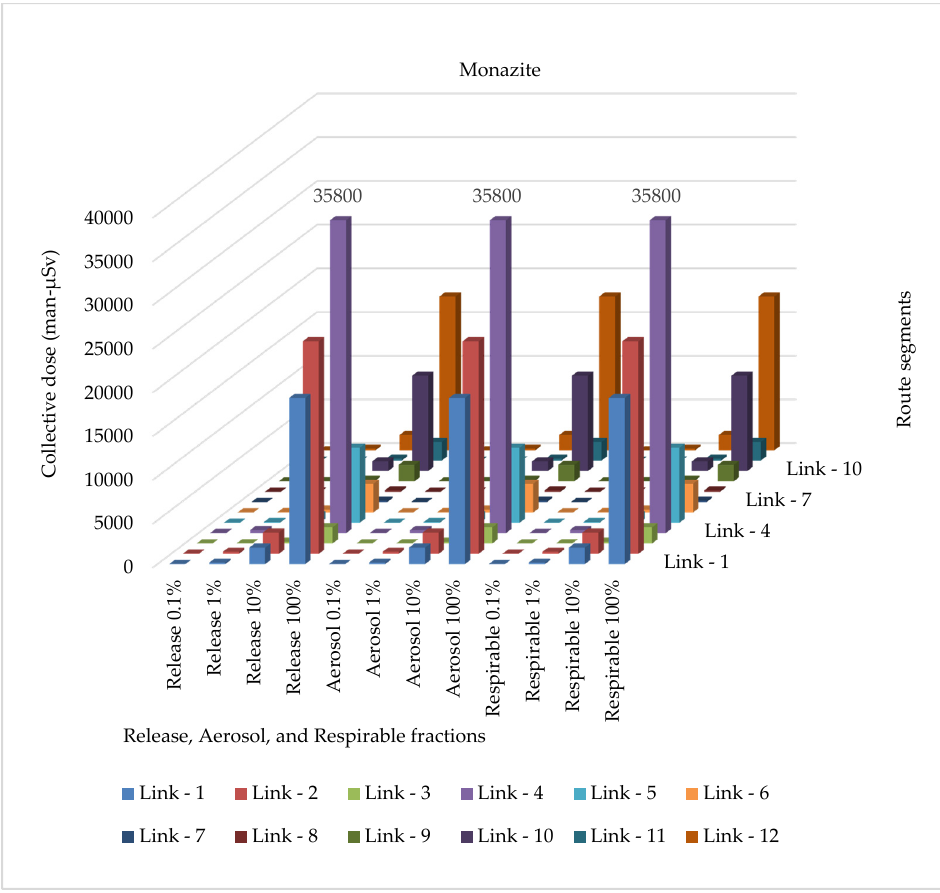
Figure 7. Sensitivity analysis result of monazite (NORM).